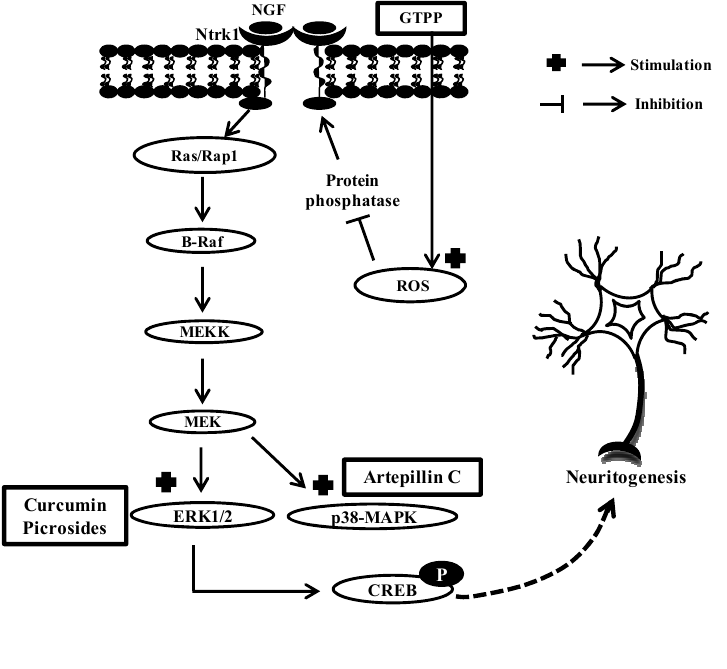
Figure 9. Schematic represents the main molecular mechanisms involved in neurite outgrowth shown by molecules from natural